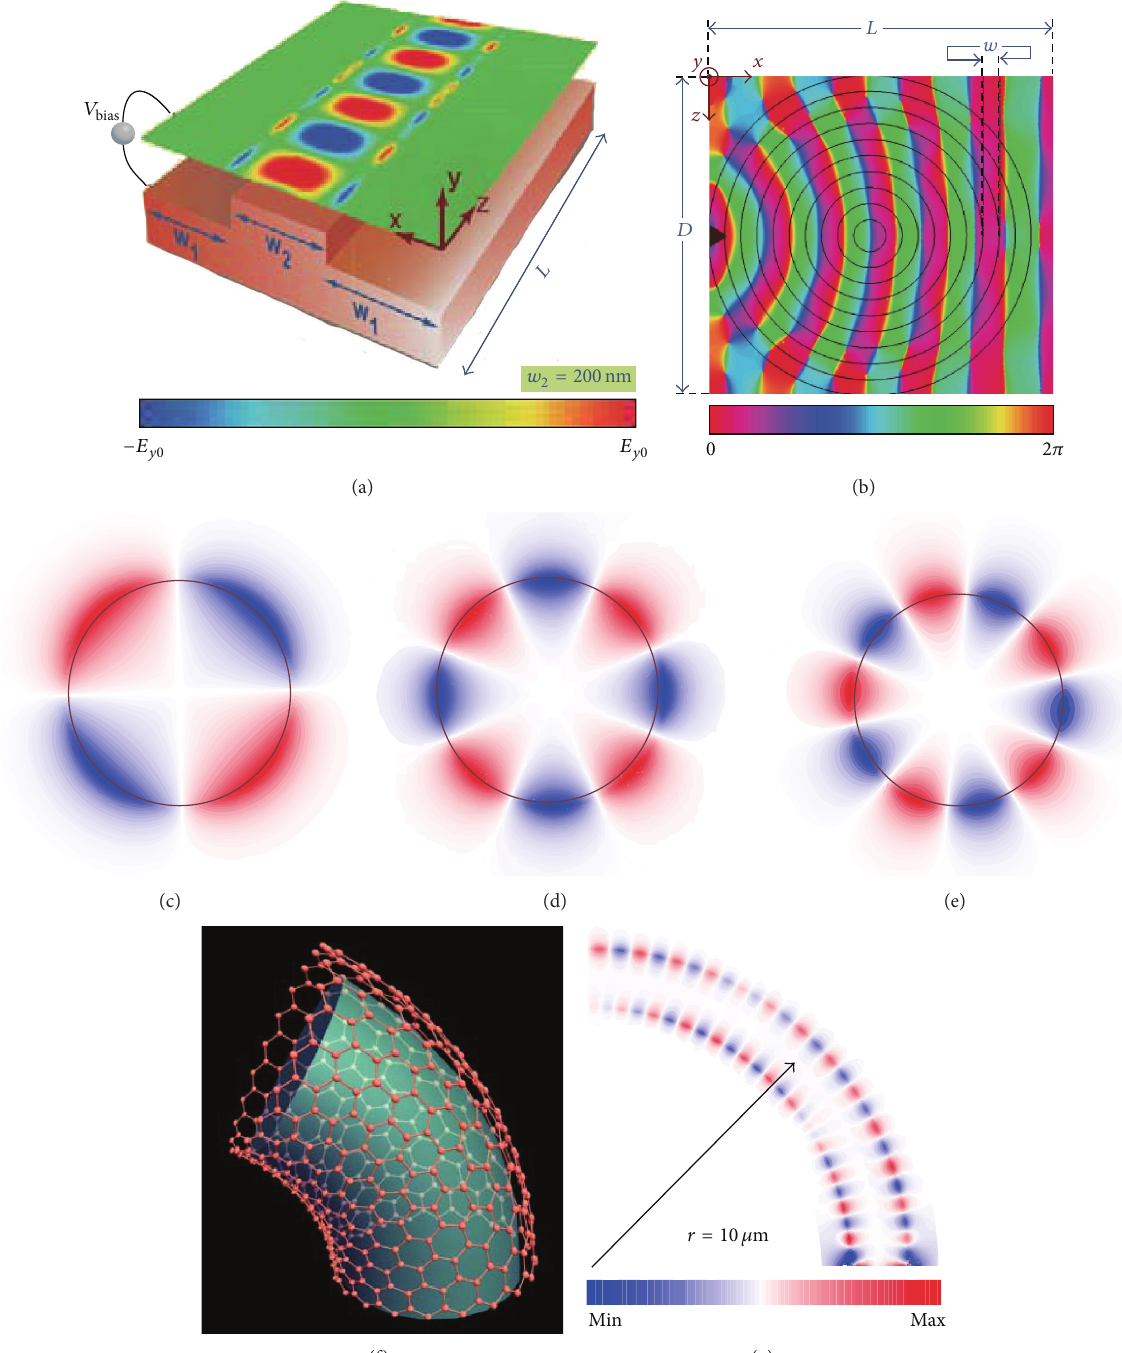
Figure 51: (a) Simulation results of 𝐸 𝑦 (snapshot in time) for a guided wave at 𝑓 = 30 THz along the ribbon-like section of graphene. (b) One atom-thick Luneburg lens. (c)–(e) Electric fields for the eigenmodes at a graphene microtube. (f) Schematic of a bent microtube. (g) Simulated electric field distribution on the graphene microtube. (a, b) Figures are reproduced from [54].